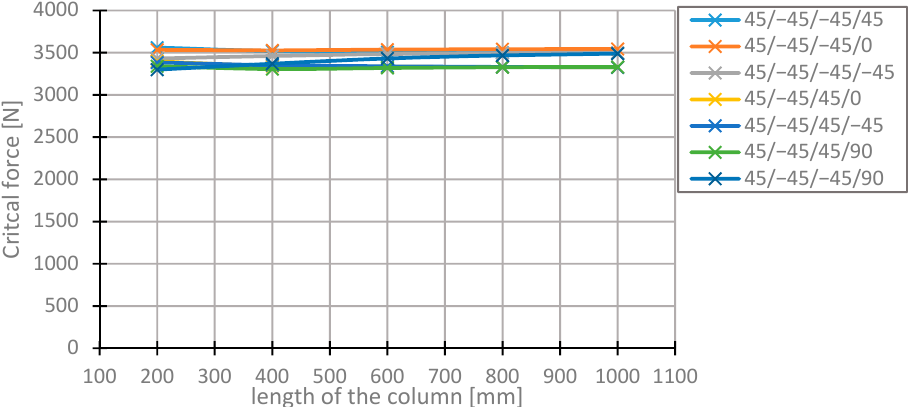
Figure 4. Changes in the value of the critical force for different arrangements of the laminate layers and different lengths of the column.